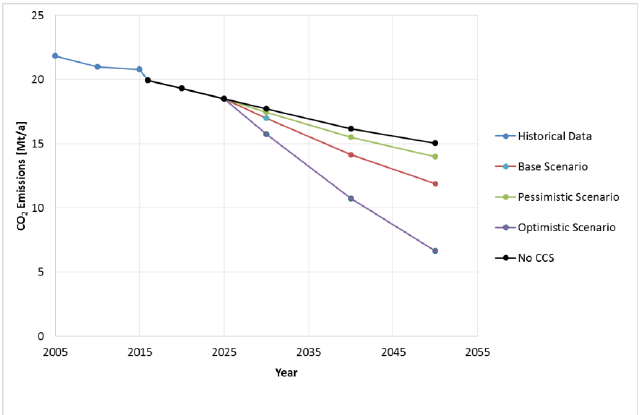
Figure 8. CCUS Germany: CO 2 emission projections for base clinker production (historical data from UBA/VDZ [21,51]). Energies 2019 , 12 , 2432